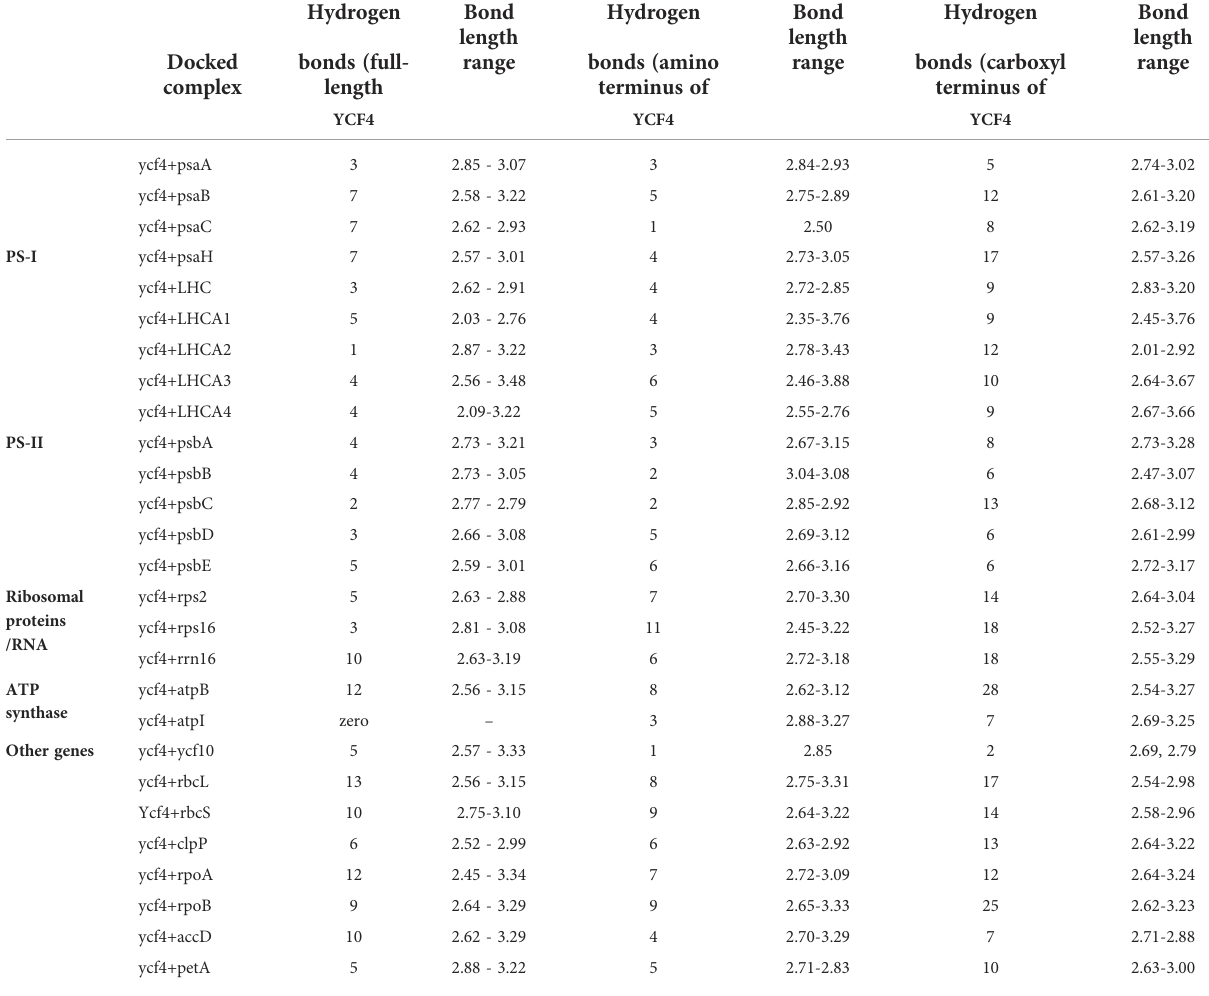
TABLE 1 Number of hydrogen bonds and the range of bonds length in docked